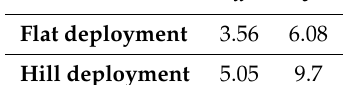
Figure 14. Link quality classification for different deployment environments.